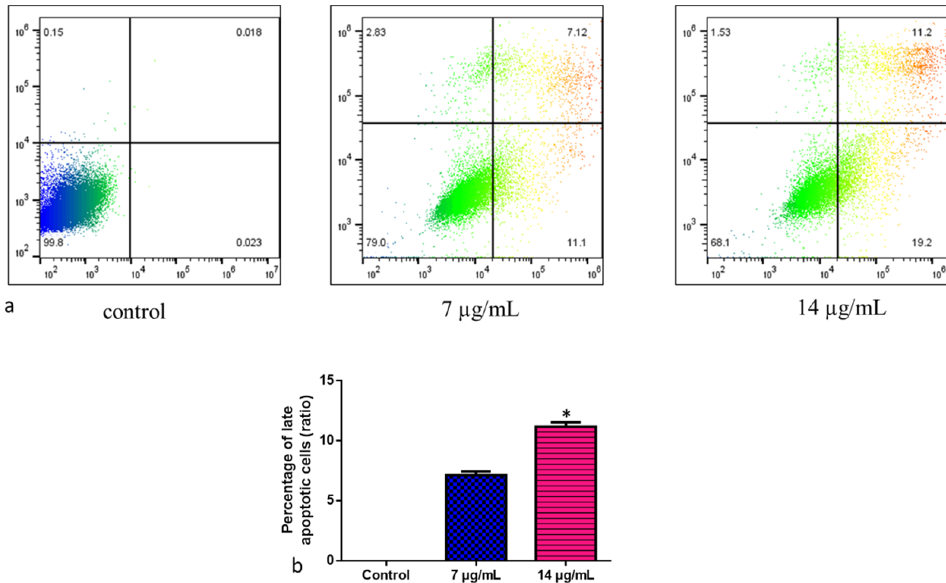
Figure 9. Representative dot plots and histograms of MOLT-4 cells stained with Annexin VFITC and PI. ( a ) The cell lines MOLT-4 were treated or left untreated (control) with nanocomposites (7 and 14 µ g/mL) for 24 h. Apoptosis was then evaluated by FACS study. The percentage of viable cells were reported in Q4; the amount of early apoptotic cells were reported in Q3; the amount of late apoptotic cells was reported in Q2; the percentage of non-viable necrotic cells was reported in Q1. A minimum of 3 separate experiments were carried out in triplicate for each sample. 2 × 10 4 events were acquired for each sample. ( b ) Values are expressed as mean ± SD. * p < 0.05 vs.